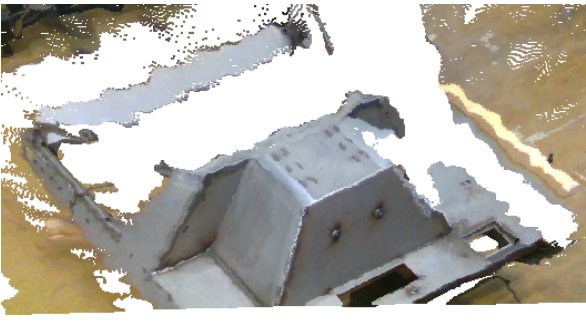
Figure 7: Colored 3D depth image captured with RealSenseD415 [12]